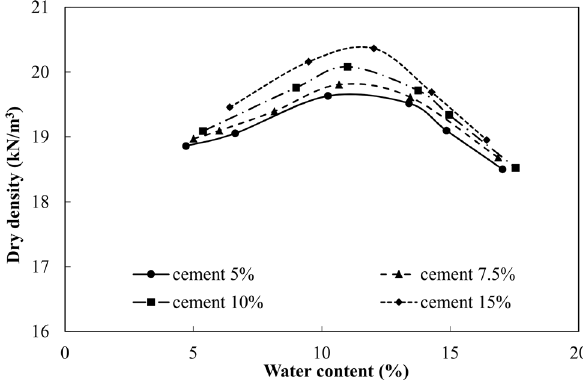
Fig. 5 The dry density–water content graph of CSG mixtures in compaction